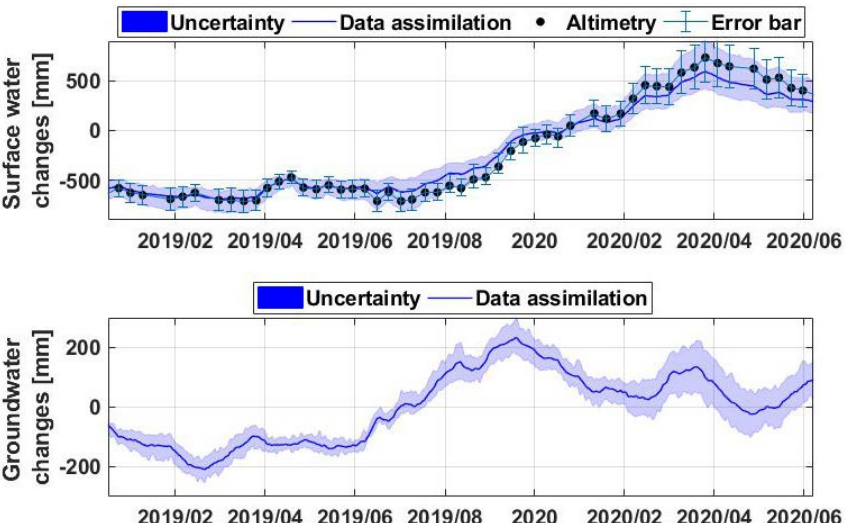
Figure 4. Average surface water ( top ) and groundwater ( bottom ) changes over LV. The associated uncertainties derived from the model ensemble are also displayed for both water components. Altimetry results with their errors are presented in the top panel against the data assimilation surface water storage